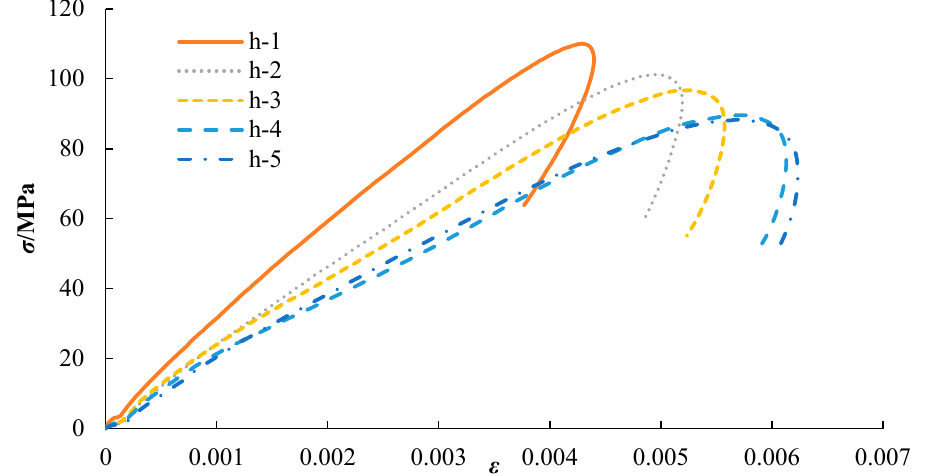
Figure 3. Stress-strain curves of half-saturated Figure 3. Stress ‐ strain curves of half ‐ saturated samples. Figure 3. Stress ‐ strain curves of half ‐ saturated samples.